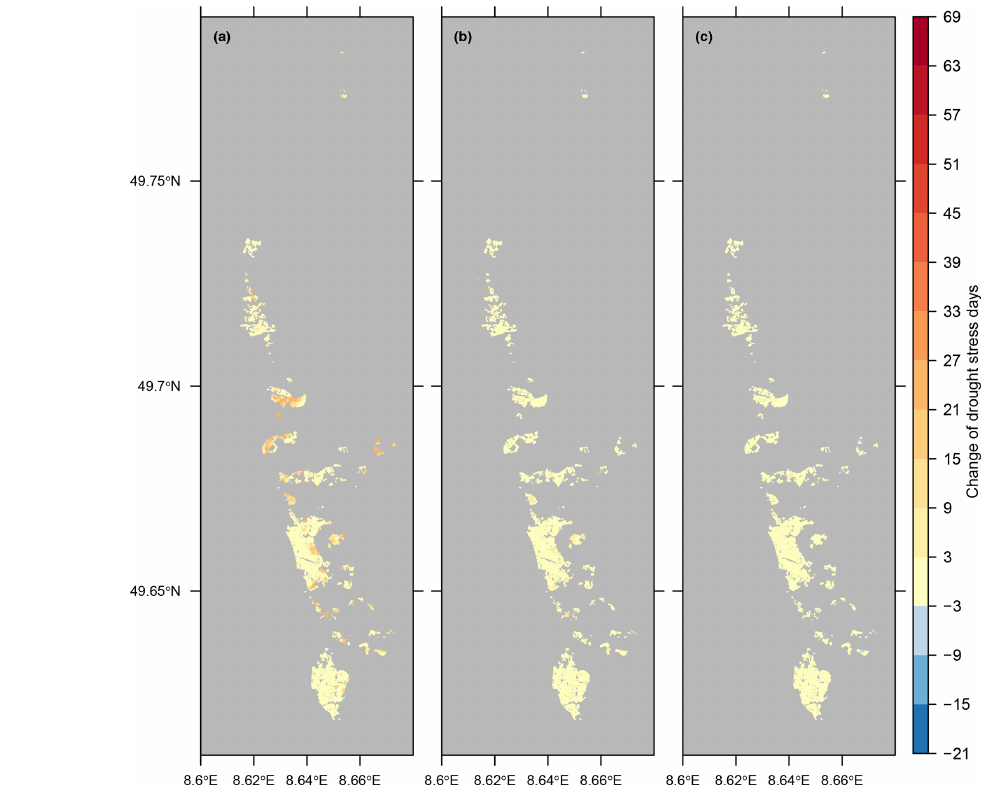
Figure 12. Projected change in the occurrence of drought stress days for the growing region Hessische Bergstraße (Germany) for the emission scenario RCP8.5, calculated with a water balance model on the assumption of cover crop use in every row. The maps show the difference between the number of the mean drought stress days per vegetation period (1 May–30 September) for the periods 2041–2070 minus 1989–2018 at the spatial scale of the individual vineyard plots. (a) Results of the climate simulation calculating the strongest increase, (b) the simulation close to the ensemble median, and (c) the simulation projecting the strongest decrease in the drought stress area of an ensemble of 10 climate